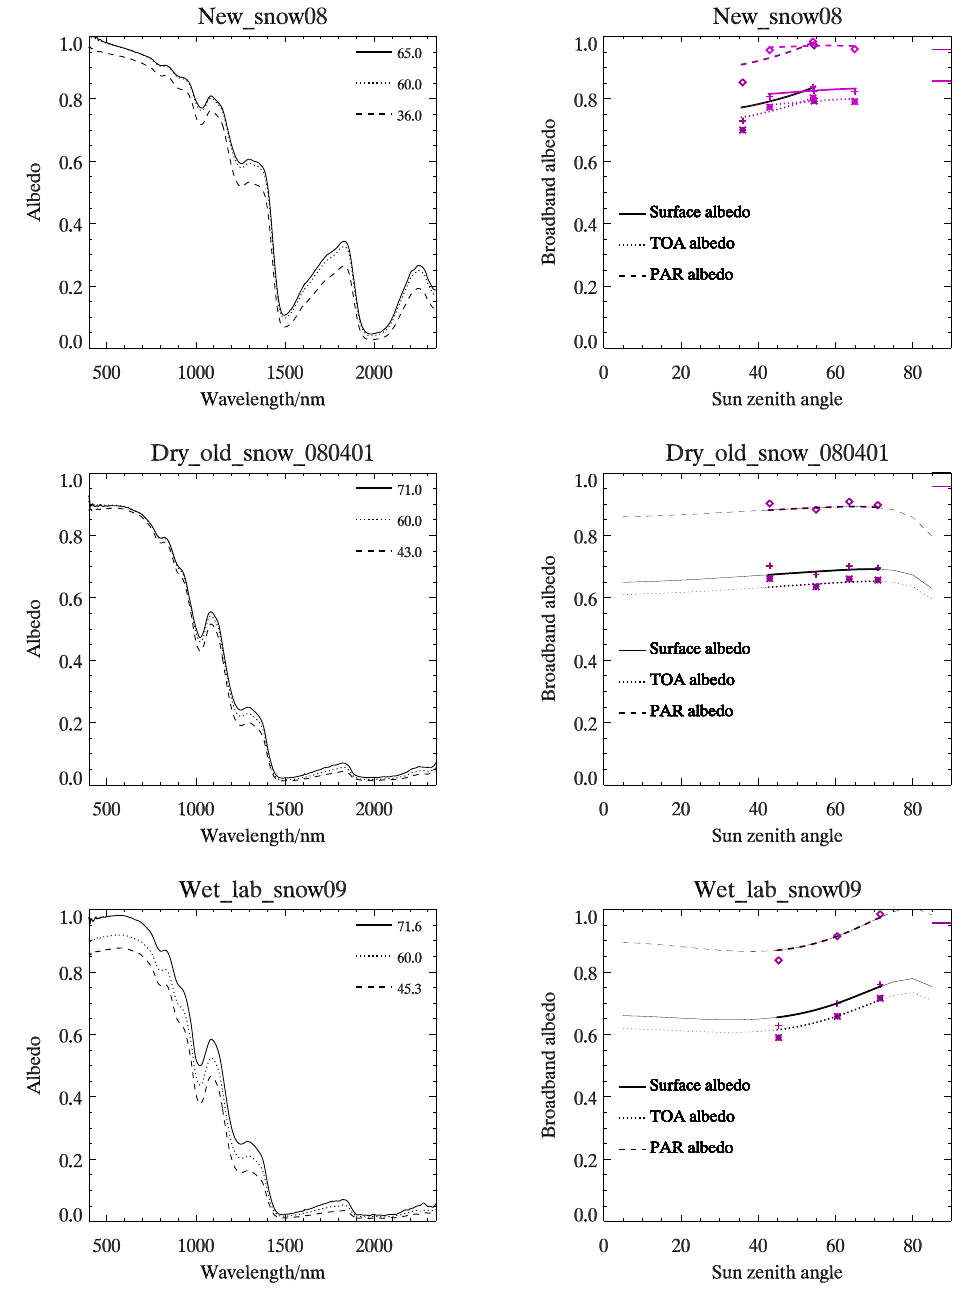
Figure 5. Left: The spectrally-resolved hemispherical albedo at three angles of incidence: maximum, minimum and 60 ◦ (interpolated). Right: recovered broadband surface albedo (solid line, +), TOA albedo (dotted line, x) and PAR albedo (dashed line, diamond) as a function of the solar zenith angle, as in Figure 4. The targets are from top down: new snow, old dry snow, wet